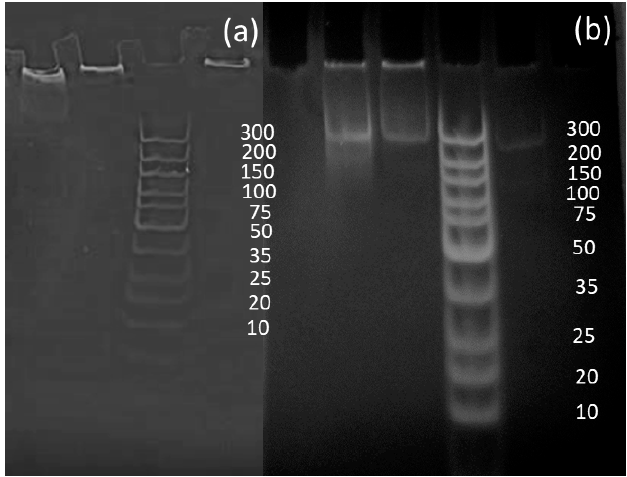
Figure 4. Amplifications of Escherichia coli samples ( a ) before purification and ( b ) after purification.